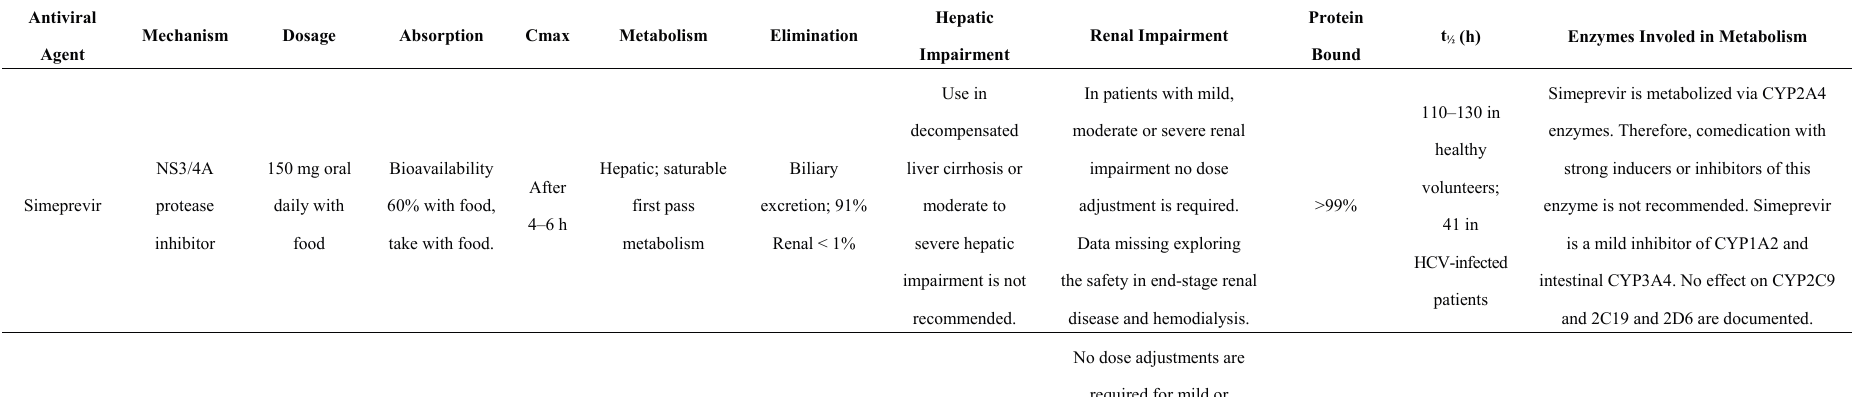
Table 1. Pharmacokinetics of direct-acting antiviral agents in hepatitis C treatment.